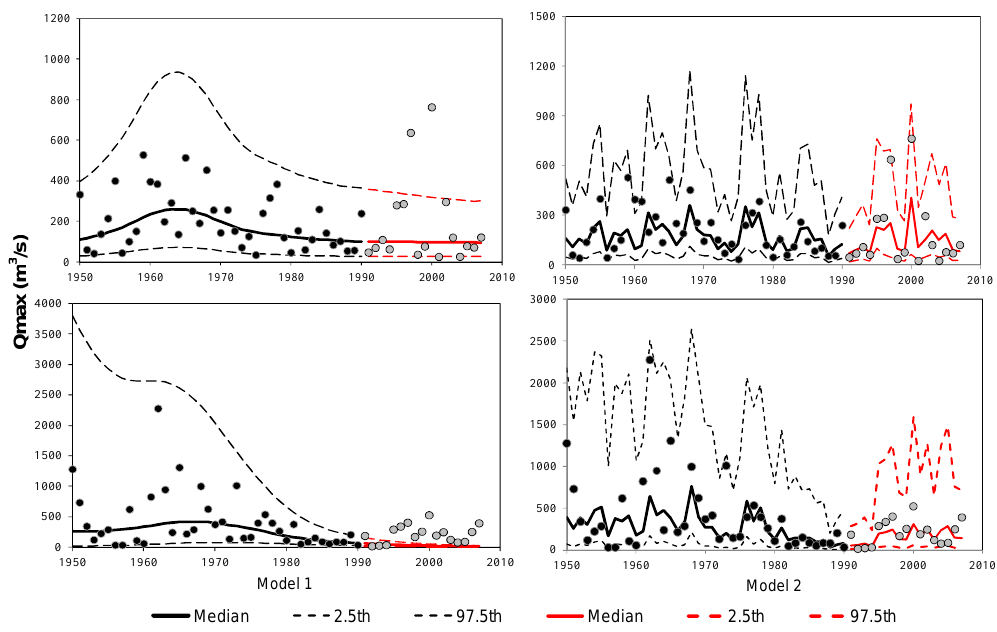
Figure 8. Results of modelling the annual maximum floods at stations 2015 (top panel, low altered regime) 800 Fig. 8. Results of modelling the annual maximum floods at stations 2015 (top panels, low altered regime) and 5004 (bottom panels, high altered regime) with models 1 and 2. Only the period 1950–1990 is used for fitting the models (black circles and lines). The models are then and 5004 (bottom panel, high altered regime) with models 1 and 2. Only the period 1950-1990 is used for 801 used as predictive tools (red lines) for the period 1991–2007 and observations not used in the fitting are shown with grey fitting the models (black circles and lines). The models are then used as predictive tools (red lines) for the 802 period 1991-2007 and observations not used in the fitting are shown with grey circles. 803